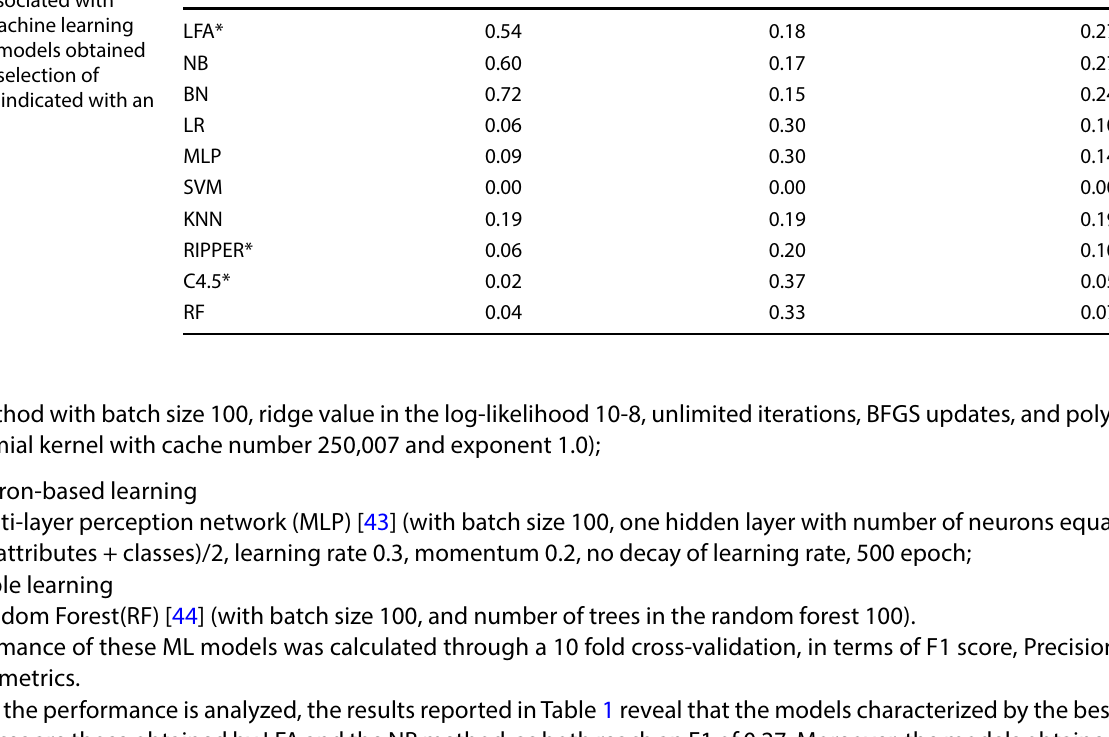
Table 1 Performance indicators associated with the tested machine learning models (the models obtained through the selection of variables are indicated with an